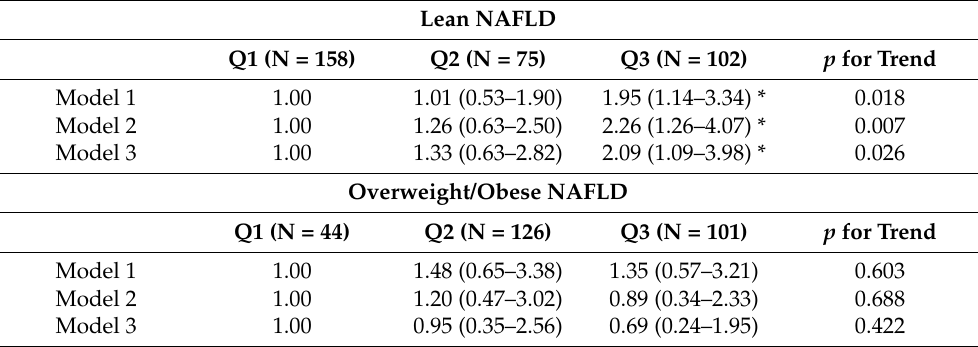
Table 4. Odds ratios of having NAFLD derived from multiple logistic regression analyses in tertiles of serum fetuin-A levels, with stratification by